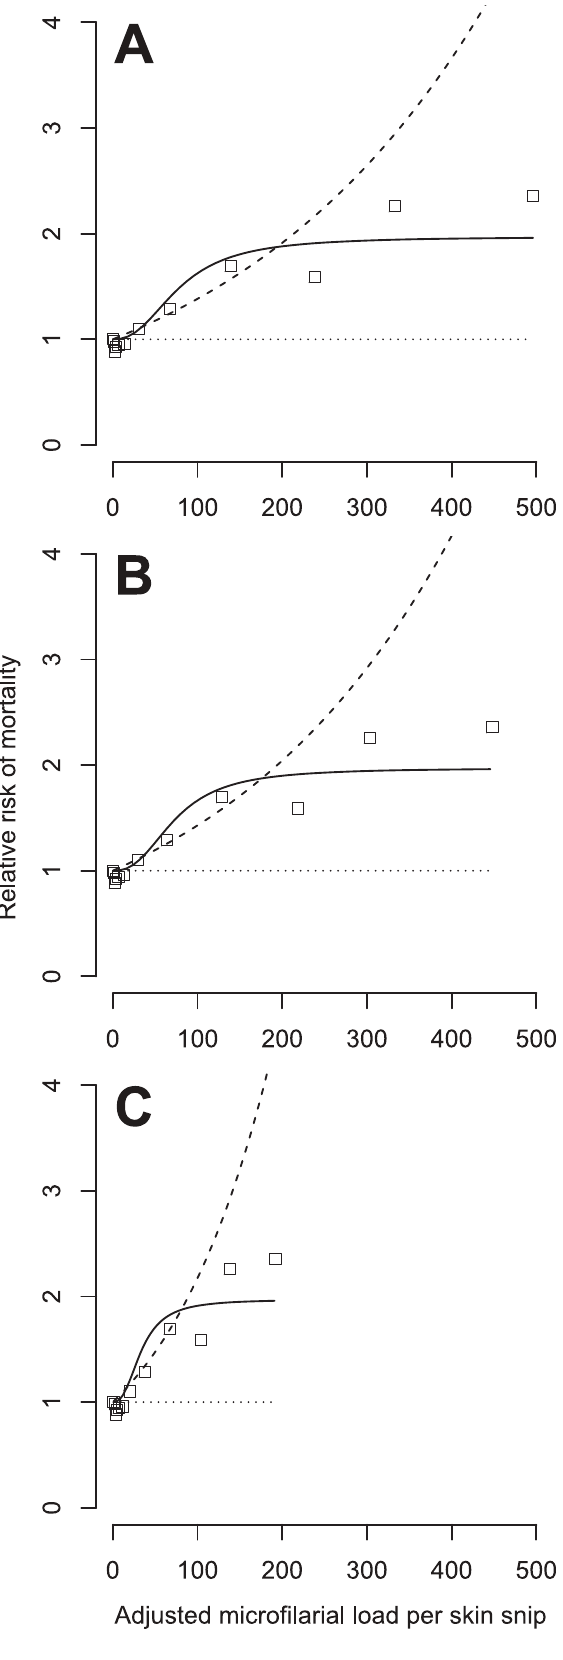
Figure 4. Measurement error-adjusted and fitted relative mortality risk in the Onchocerciasis Control Programme cohort. Panels from top to bottom correspond to adjustments for increasing assumed magnitudes of measurement error as defined by parameter k of the negative binomial measurement error model (see Measurement Error section in the main text). In panel A, k R ‘ , corresponding to Poisson measurement error. In panel B, k =15, as estimated from published data [43] (Protocol S3). In panel C, k =1. In all panels the solid and dashed lines represent, respectively, the fitted (log- )sigmoid and (log-)linear dose-response models. Note the absence of error bars around the model-derived point estimates of relative risk (Protocol S1) and around the fitted dose-response. This is because regression calibration cannot account fully for the uncertainty introduced by adjusting the observed data for measurement error (see